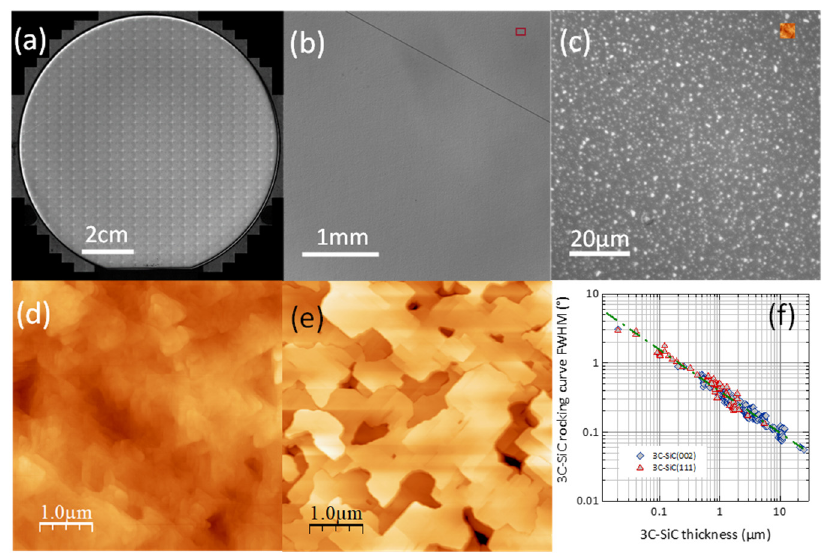
Figure 6. ( a ) Composite image of the 3C-SiC/Si(111) epiwafer W1, ( b ) broad field (×2.5 objective) image showing high quality as-grown surface with locally appearing cracks, ( c ) surface detail (x100 objective) with visible interfacial voids, ( d ) AFM image of the 3C-SiC(111) surface, ( e ) AFM image of the 3C-SiC(100) surface, ( f ) reduction of 3C-SiC rocking curve FWHM with increasing film thickness, attesting progressive reduction of intrinsic defect density.